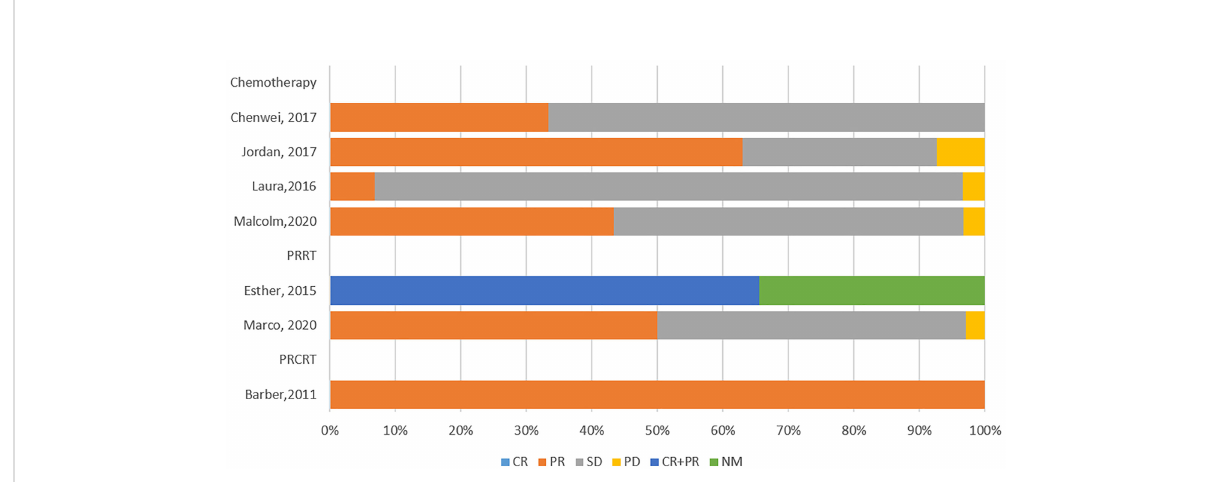
FIGURE 3 The tumor response of the included